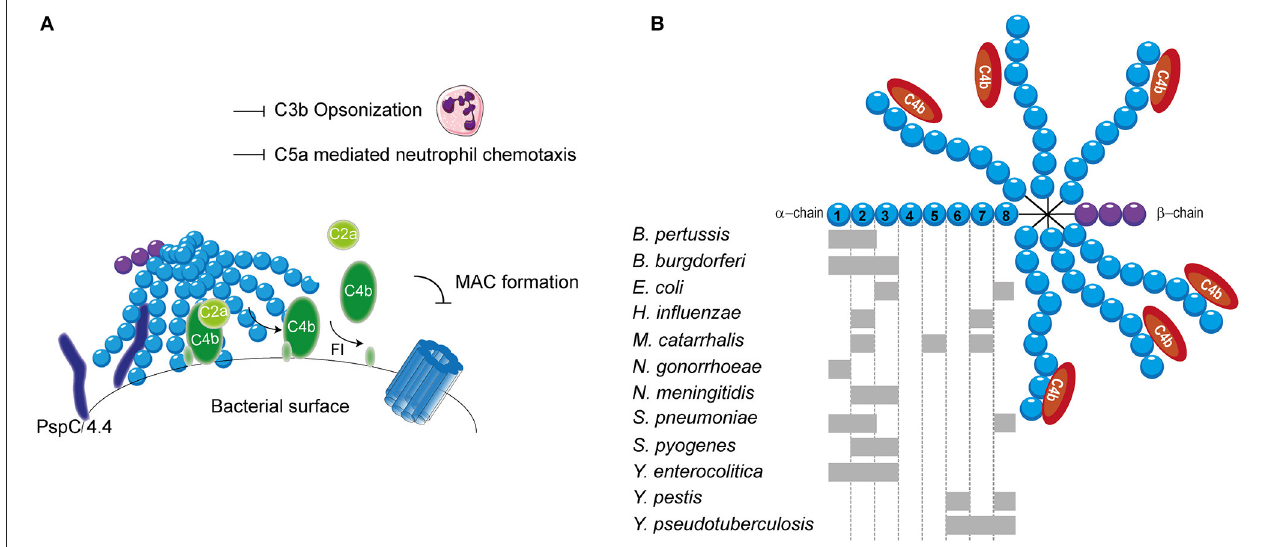
FIGURE 4 | C4BP recruitment by bacterial pathogens. (A) PspC4.4 of S. pneumoniae recruits C4BP to the bacterial surface resulting in the decay of CP and LP C3 convertase and proteolytic cleavage of C4b. This subsequently inhibits formation of the MAC as well as decreases phagocytic uptake of the bacteria due to the inhibition of C3b deposition and C5a generation. (B) Multiple bacteria can bind the α -chain of C4BP at different sites as indicated by the gray rectangles. SCRs 1-3 of the α -chain mediate the interaction with C4b. Figure was produced using Servier Medical Art.